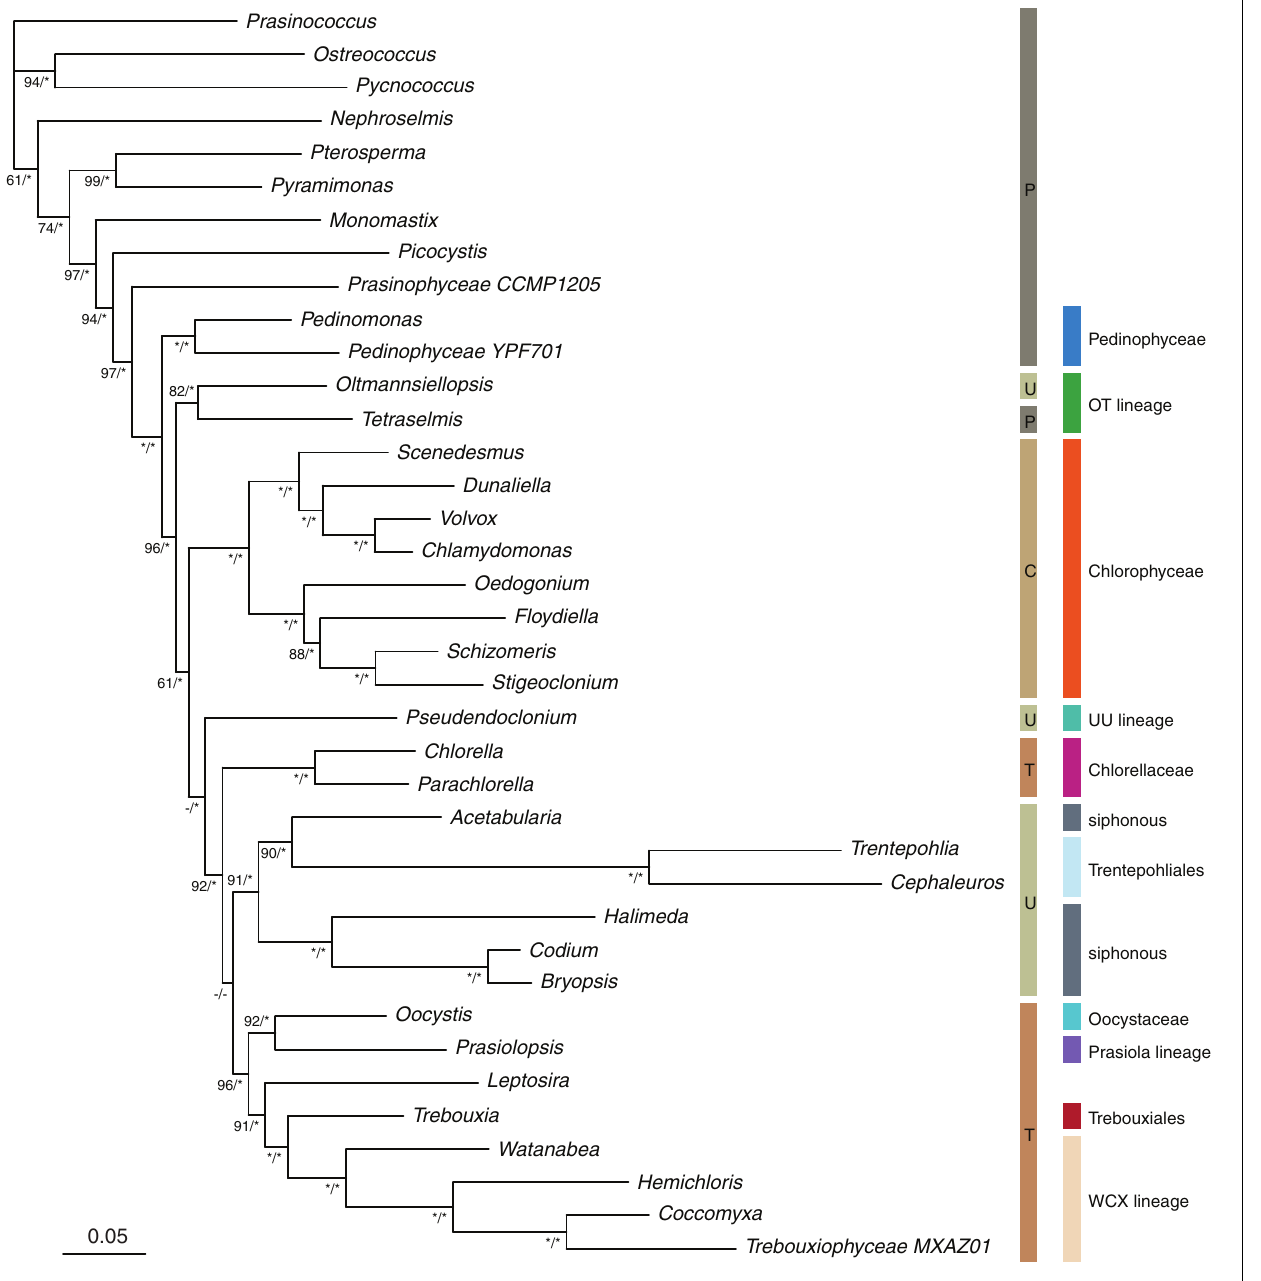
FIGURE 3 | Maximum likelihood phylogeny inferred from the genome-scale alignment (80% slowest sites). Bootstrap percentages and Bayesian posterior probabilities (MrBayes) are indicated along branches. The classical classication into Prasinophyceae (P), Chlorophyceae (C),